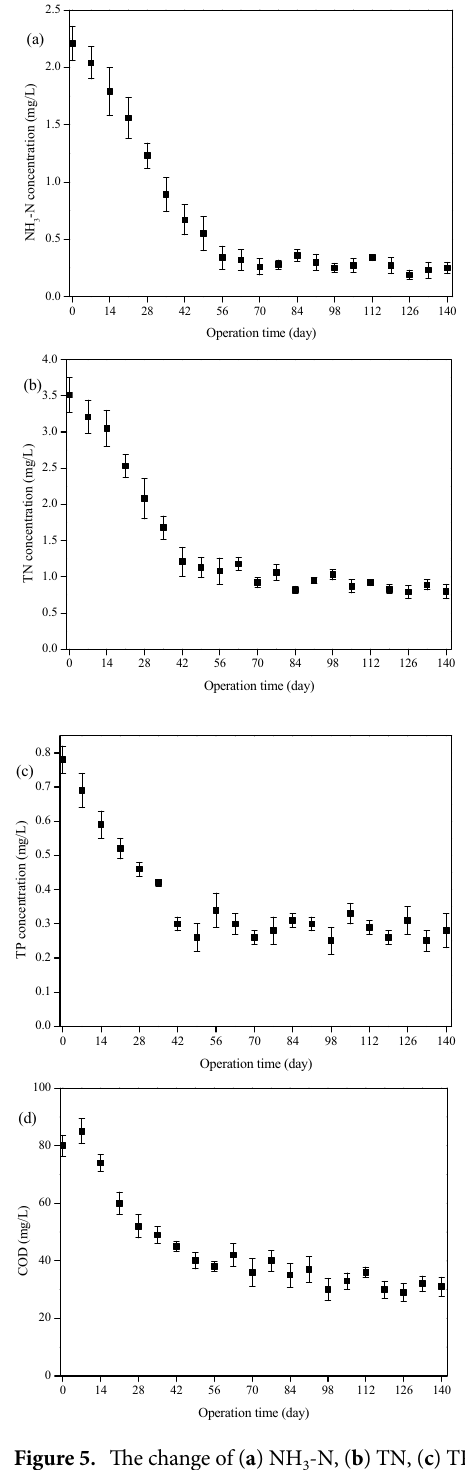
Figure 5. The change of ( a ) NH 3 -N, ( b ) TN, ( c ) TP, and ( d ) COD concentration in Kulv river installed with mussel/microalgae/bacteria treatment